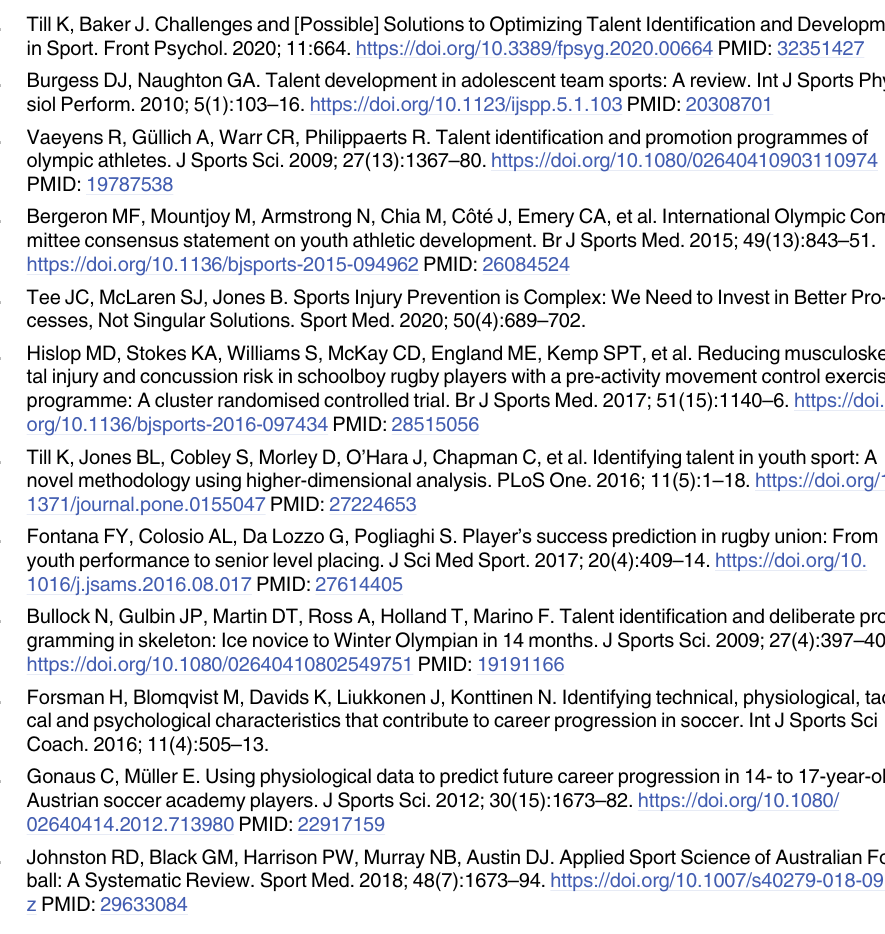
S1 Table. Study information and individual qualitative